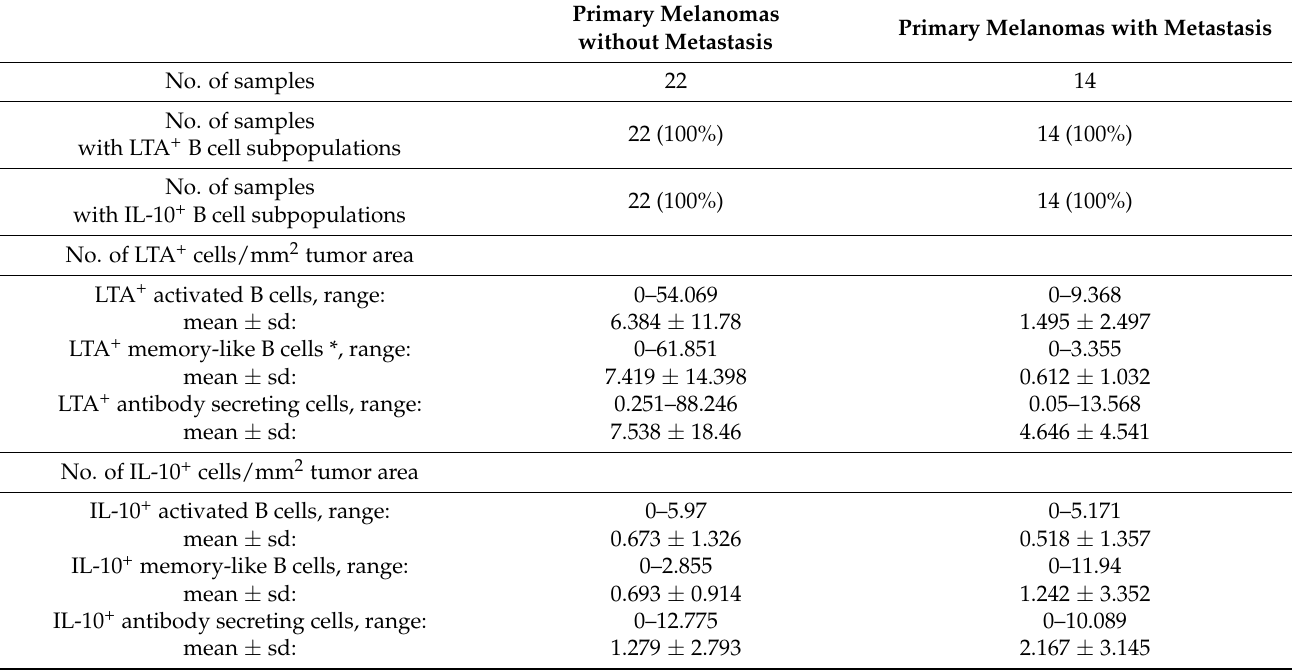
Table 3. Summary of multiplex immunohistochemistry staining results in primary tumor samples.